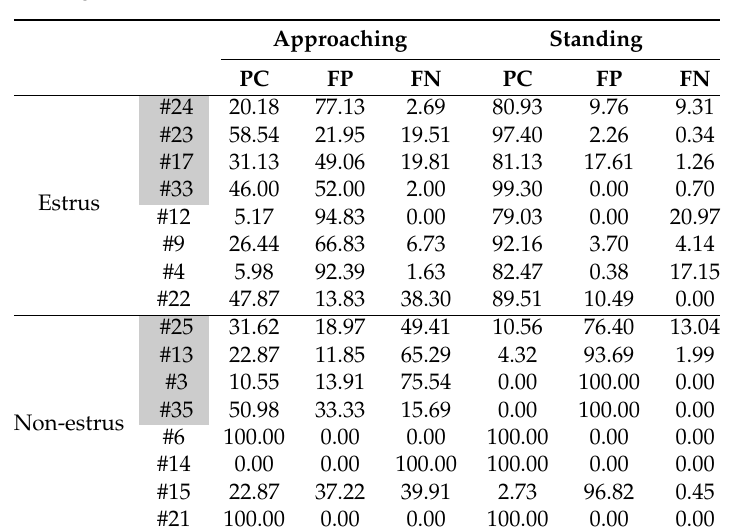
Table 1. PCs, false positives, and false negative of estimation using HMM. Gray-colored cells represent goats used for training data.